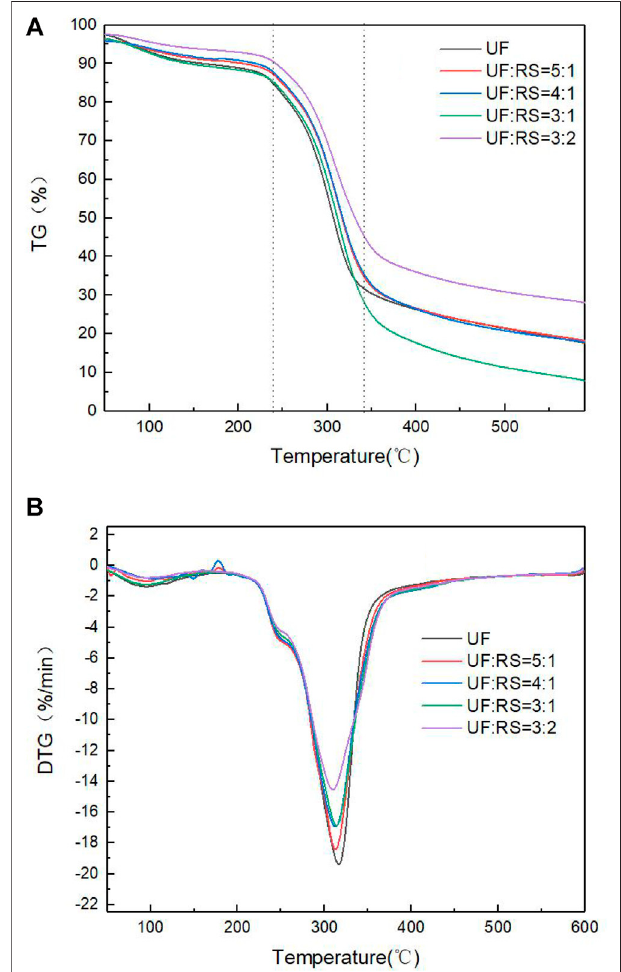
FIGURE 2 | TG curves (A) and DTG curves (B) of fi ve different